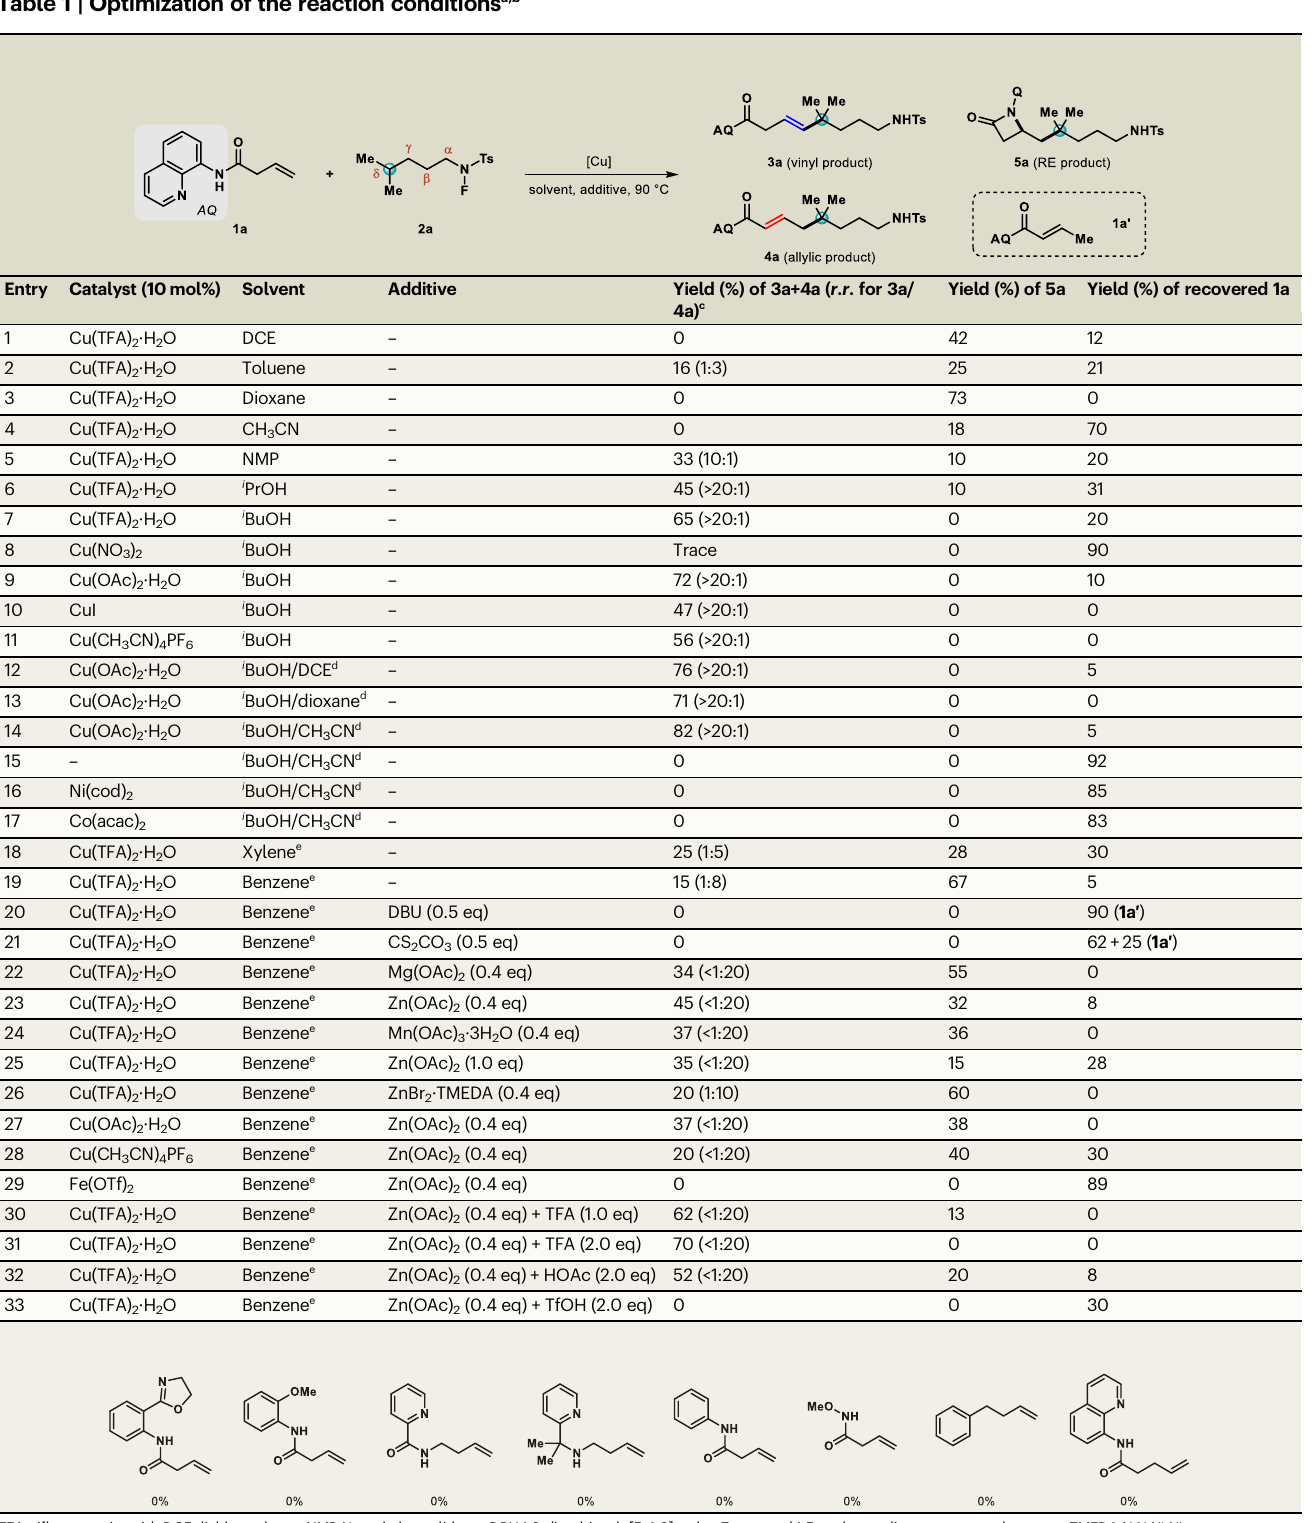
Table 1 | Optimization of the reaction conditions